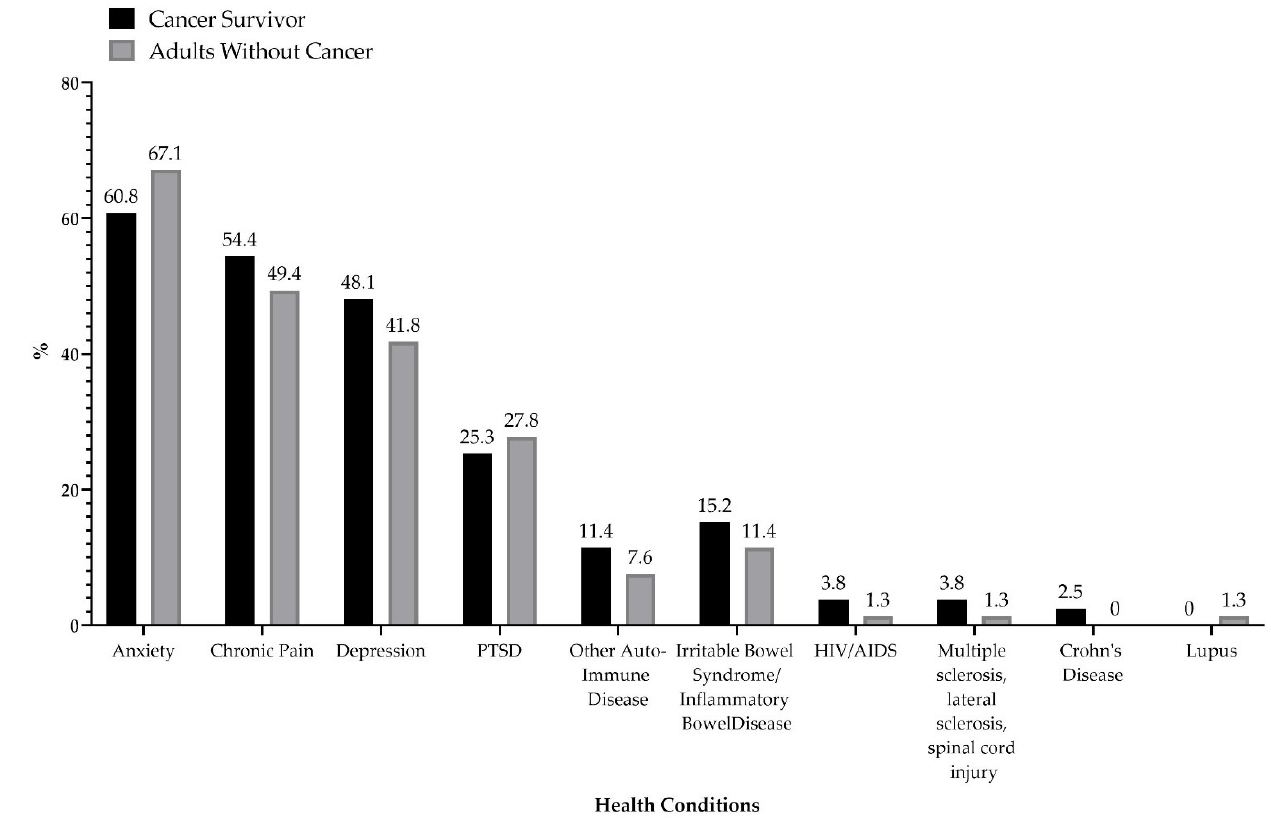
Figure 1. Frequency of Health Conditions Managed with Cannabis among the COVID-19 Cannabis Health Questionnaire